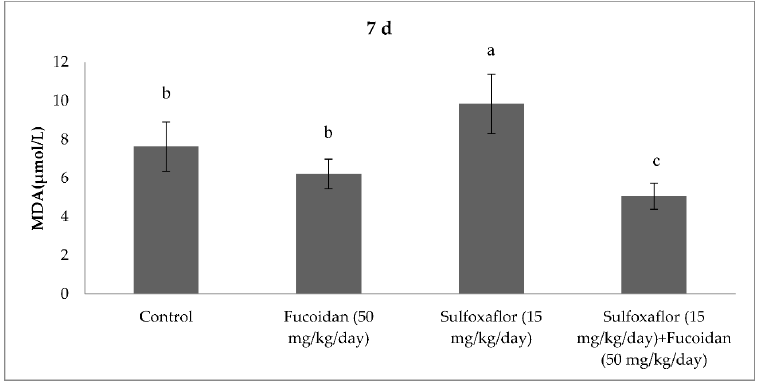
Figure 3. Effects of Sulfoxaflor and Fucoidan on MDA Levels (µmol/L) in Serum of Mice at 24-h Treatment Periods. Values are expressed as mean ± standard error. MDA: Malondialdehide. Letters a and b show the differences between treatment groups and control. Data shown in different letters are significantly different at p < 0.05 level ( n = 8). Duncan multiple comparison tests were used.